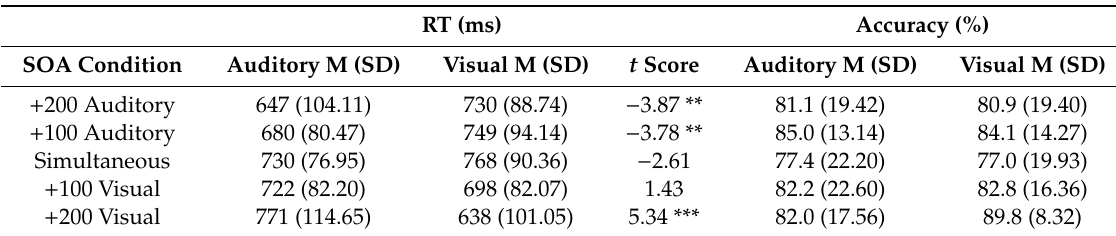
Table 4. Reaction times and accuracy scores in the 3-button task. Means, standard deviations, and t statistics from pairwise comparisons of auditory and visual oddballs.